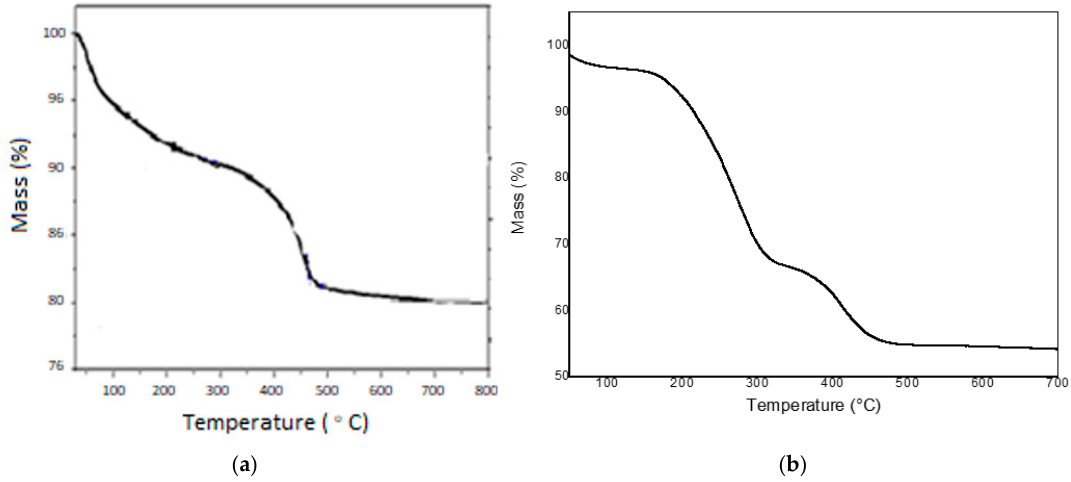
Figure 3. TGA profile of SAPO-5 catalyst ( a ); TGA profile of Al-MCM-41 catalyst ( b ).